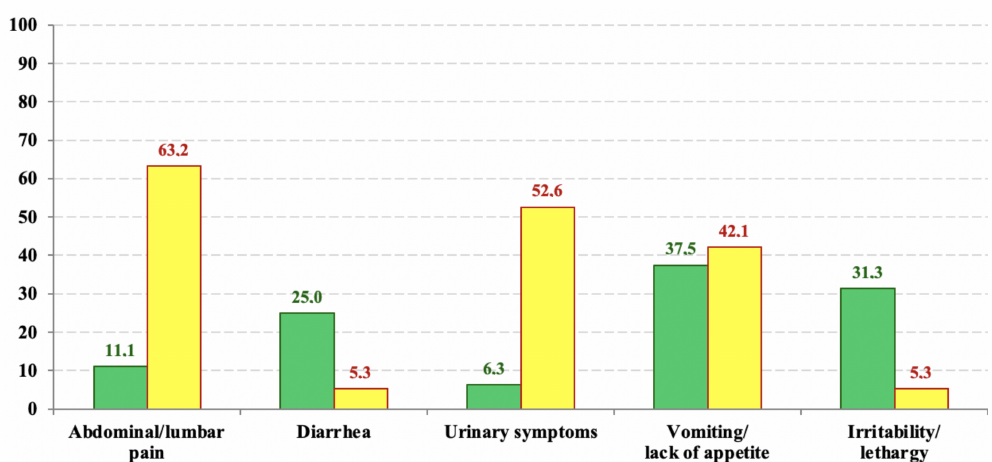
Figure 1. Prevalence (%) of symptoms in children under 2 years old (yellow columns) and in children over 2 years old (green columns).